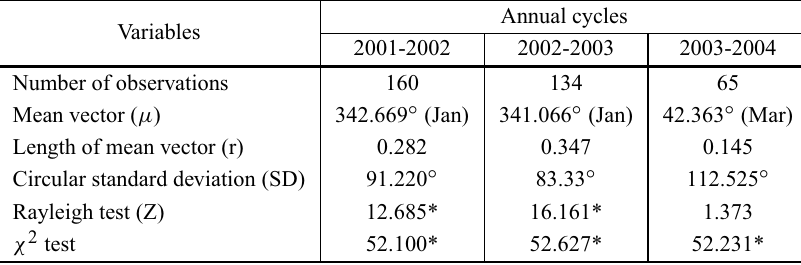
Results of circular statistical analysis testing incidence of captures seasonality of lizards from Pampean area, Brazil. (*) indicates P values significant at 1%.